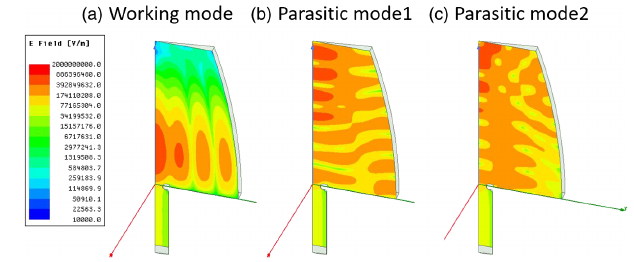
FIG. 6. Electrical fields of the working mode and the parasitic modes in the correction cavity. 8 degree slice model of the cavity with a storage energy of 1 J was simulated by the eigenmode solver of HFSS. The electrical fields are in logarithmic scale. (a) is the working mode at 11.994 GHz. (b) and (c) are the parasitic modes.